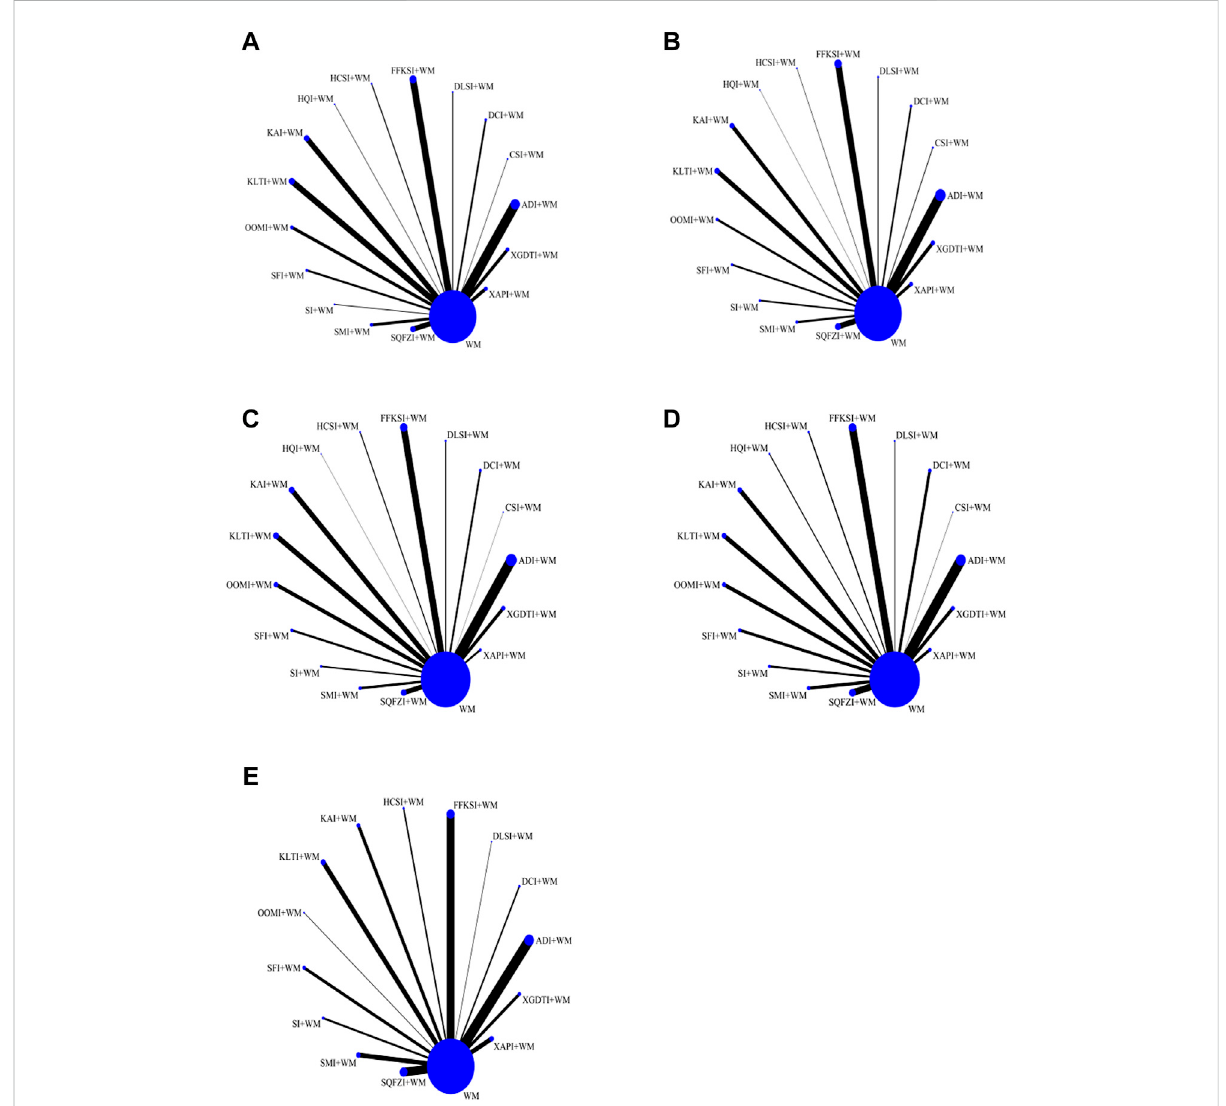
FIGURE 3 Network graphs for different outcomes. (A) Disease control rate. (B) Survival quality score. (C) Incidence of gastrointestinal adverse reactions. (D) Incidence of leukopenia. (E) Incidence of